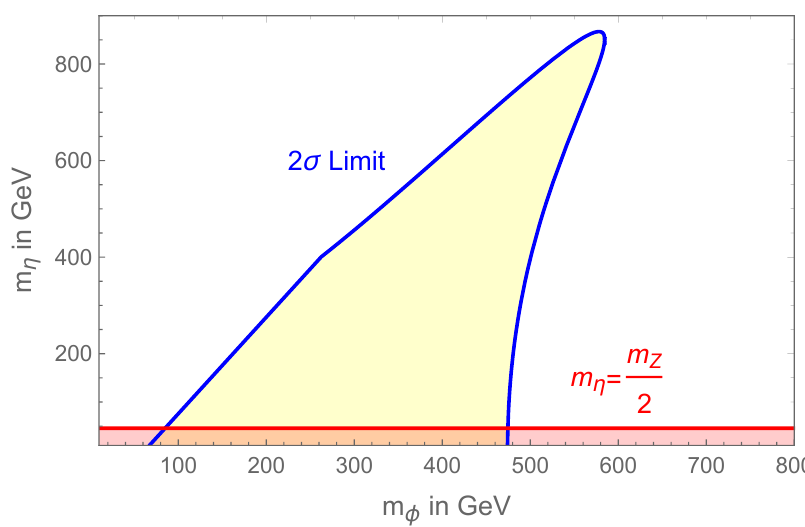
Figure 1 . In the figure, the yellow region surrounded by a blue line is the excluded parameter space by the observation of cosmic antiproton flux when h σv i φ,φ → η,h = 3 × 10 − 26 cm 3 / s. The excluded region ( m η < m Z / 2) derived from the kinetic term of Φ is also shown with the red region for